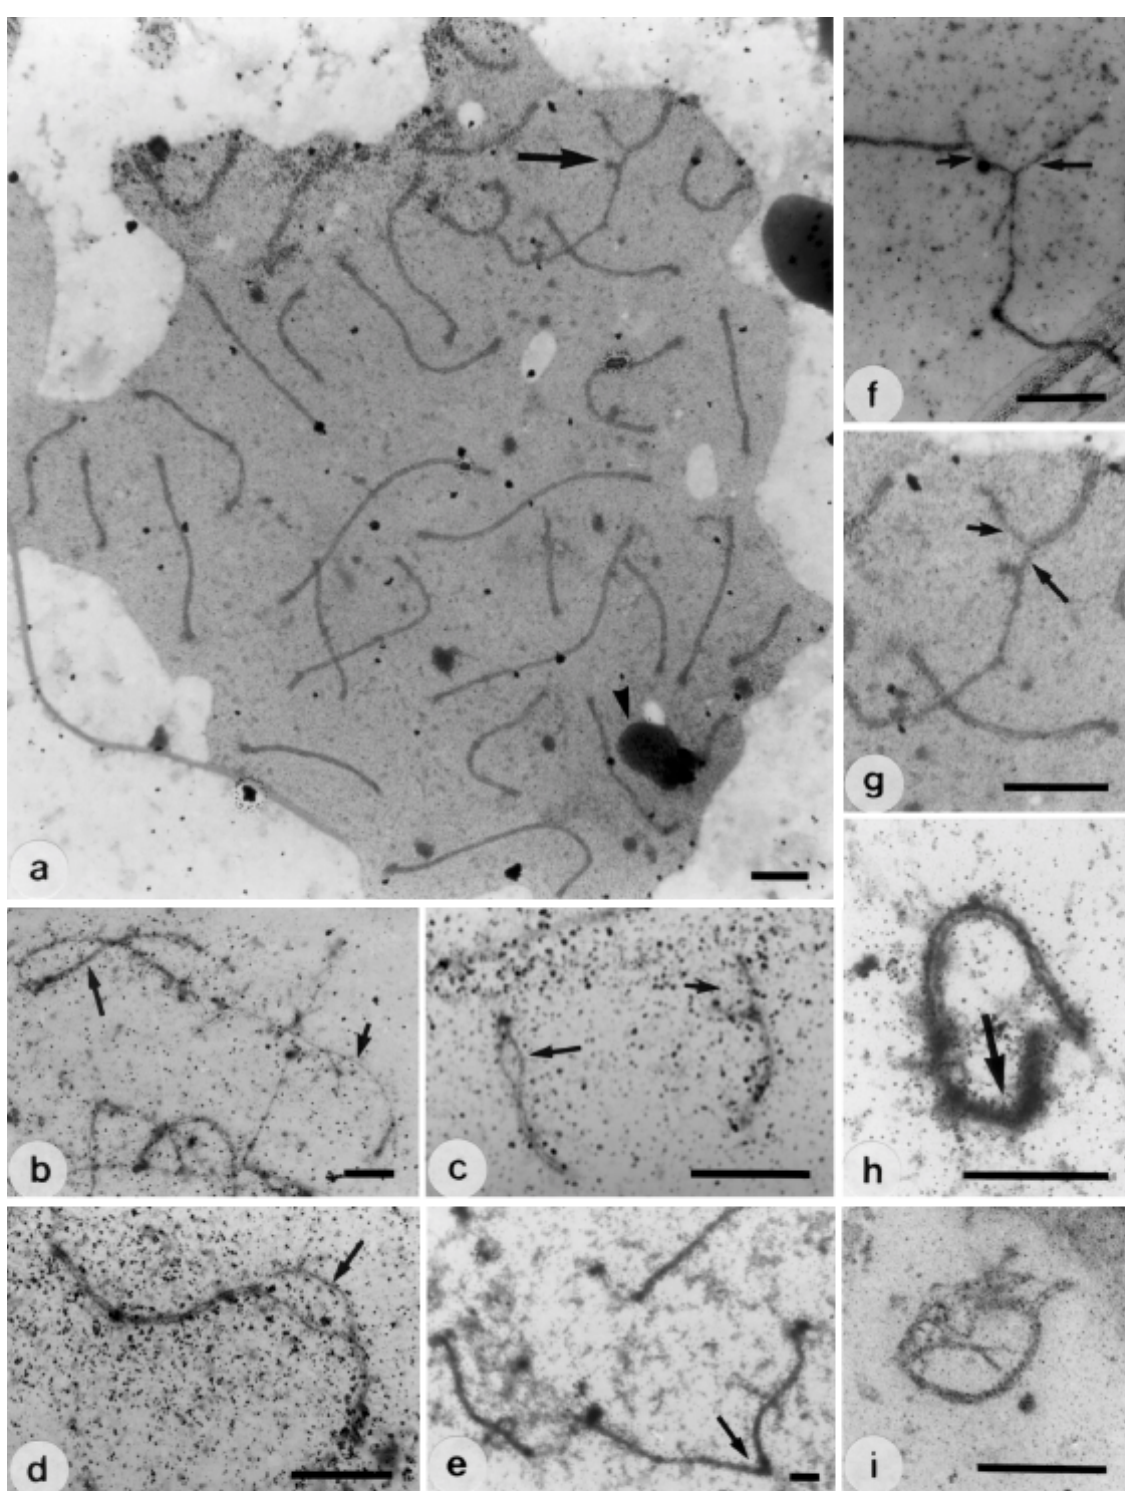
Figure 1 - Synaptonemal complex of Dasypus novemcinctus . a , Electron micrograph of a early pachytene cell with 31 autosomal bivalents and the XY sexual bivalent (arrow). The arrowhead indicates the nucleolus organizer region; b , partial synaptonemal complex showing asynchrony at the beginning of the synapsis process. Large arrow shows a totally paired bivalent and the small arrow points to a bivalent at the beginning of the pairing process; c , bivalent with unsynapsed central region (large arrow) and bivalent with only one unsynapsed extremity (small arrow); d , bivalent with unsynapsed central region (arrow); e , association of two bivalent telomeres (arrow); f , late zygotene showing that X (large arrow) and Y (small arrow) chromosome lateral elements remain close but not synapsed; g , early pachytene showing the beginning of pairing of the sexual chromosomes; the large arrow shows the X chromosome and the small arrow shows the Y chromosome; h , medium pachytene showing total pairing of the sexual chromosomes. The unsynapsed portion becomes heteropycnotic (arrow); i , late pachytene showing sexual vesicle. Scale = 2 µ